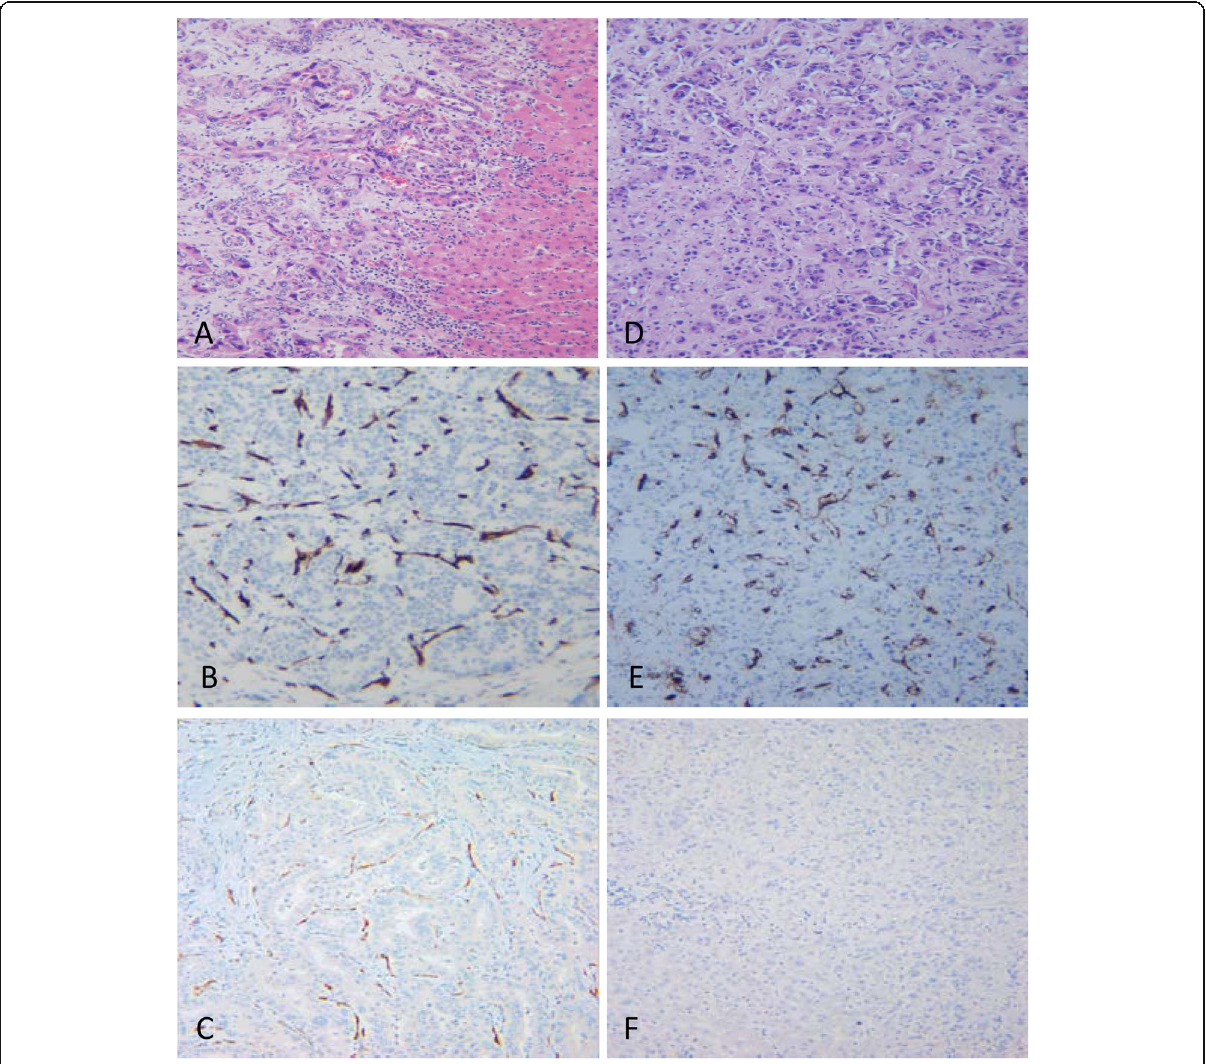
Fig. 2 Primary cholangiocarcinoma and metastatic pancreatic ductal adenocarcinoma. a . Primary cholangiocarcinoma (HE, 100x); b . CD34 expression in cholangiocarcinoma (CD34, 200x); c . PSMA peritumoral/vascular expression in cholangiocarcinoma (PSMA, 200x). d . Metastatic pancreatic ductal adenocarcinoma in liver (HE, 100x) e . CD34 expression in pancreatic ductal adenocarcinoma (CD34, 200x); f . PSMA is negative in metastatic pancreatic ductal adenocarcinoma (PSMA,